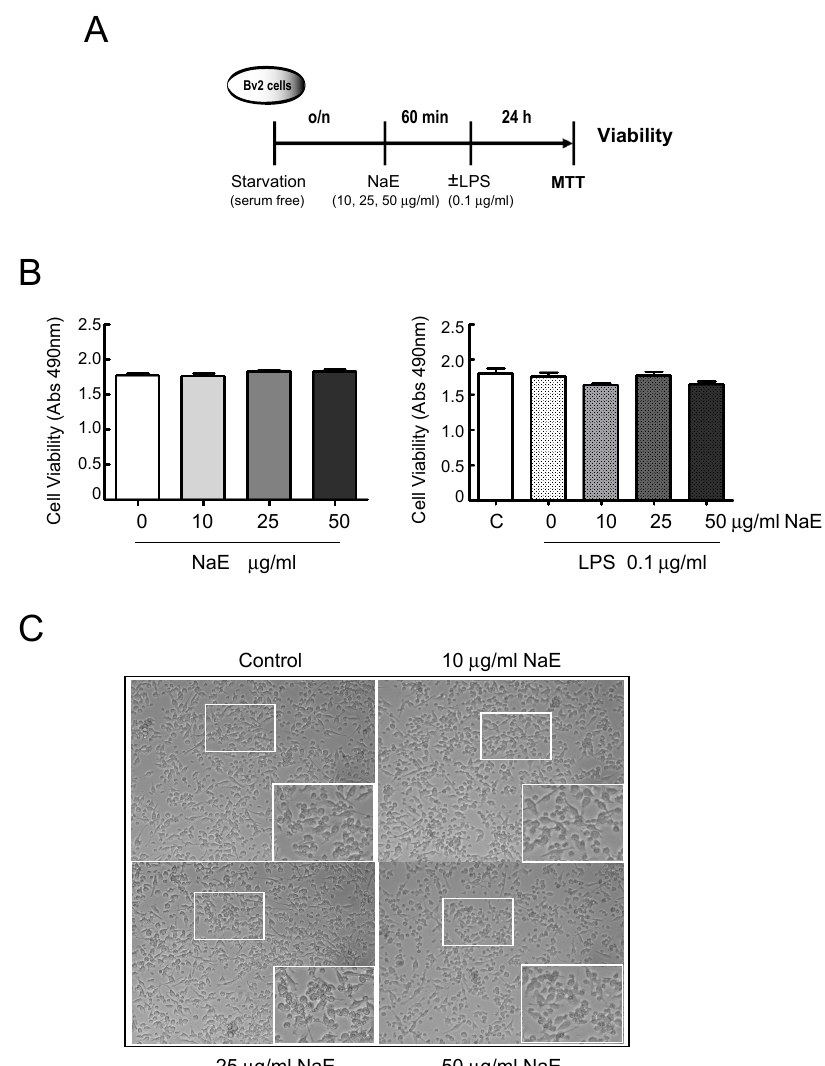
Figure 1. Effect of NaE extract on the viability of BV2 microglia. ( A ) Experimental steps. ( B ) BV2 cells were treated with the indicated doses of the NaE extract in the absence or presence of 0.1 µg/mL LPS for 24 h. Cell viability was measured using an MTT assay. Values are expressed as the mean ± SD of the three independent experiments. ( C ) Representative photomicrographs of cells incubated with medium (control) or NaE (10, 25 and 50 µg/mL) for 24 h. Images were taken at 100× and 40× magnification. N = 3.